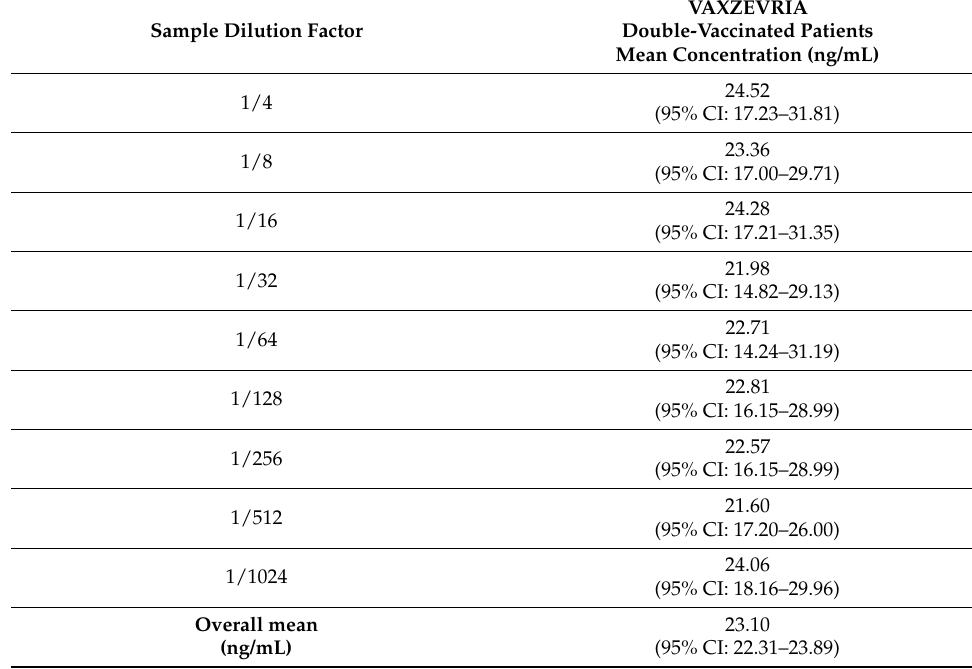
Table 2. The concentration of protein S in the supernatant obtained for the different dilutions of the Vaxzevria ® controls